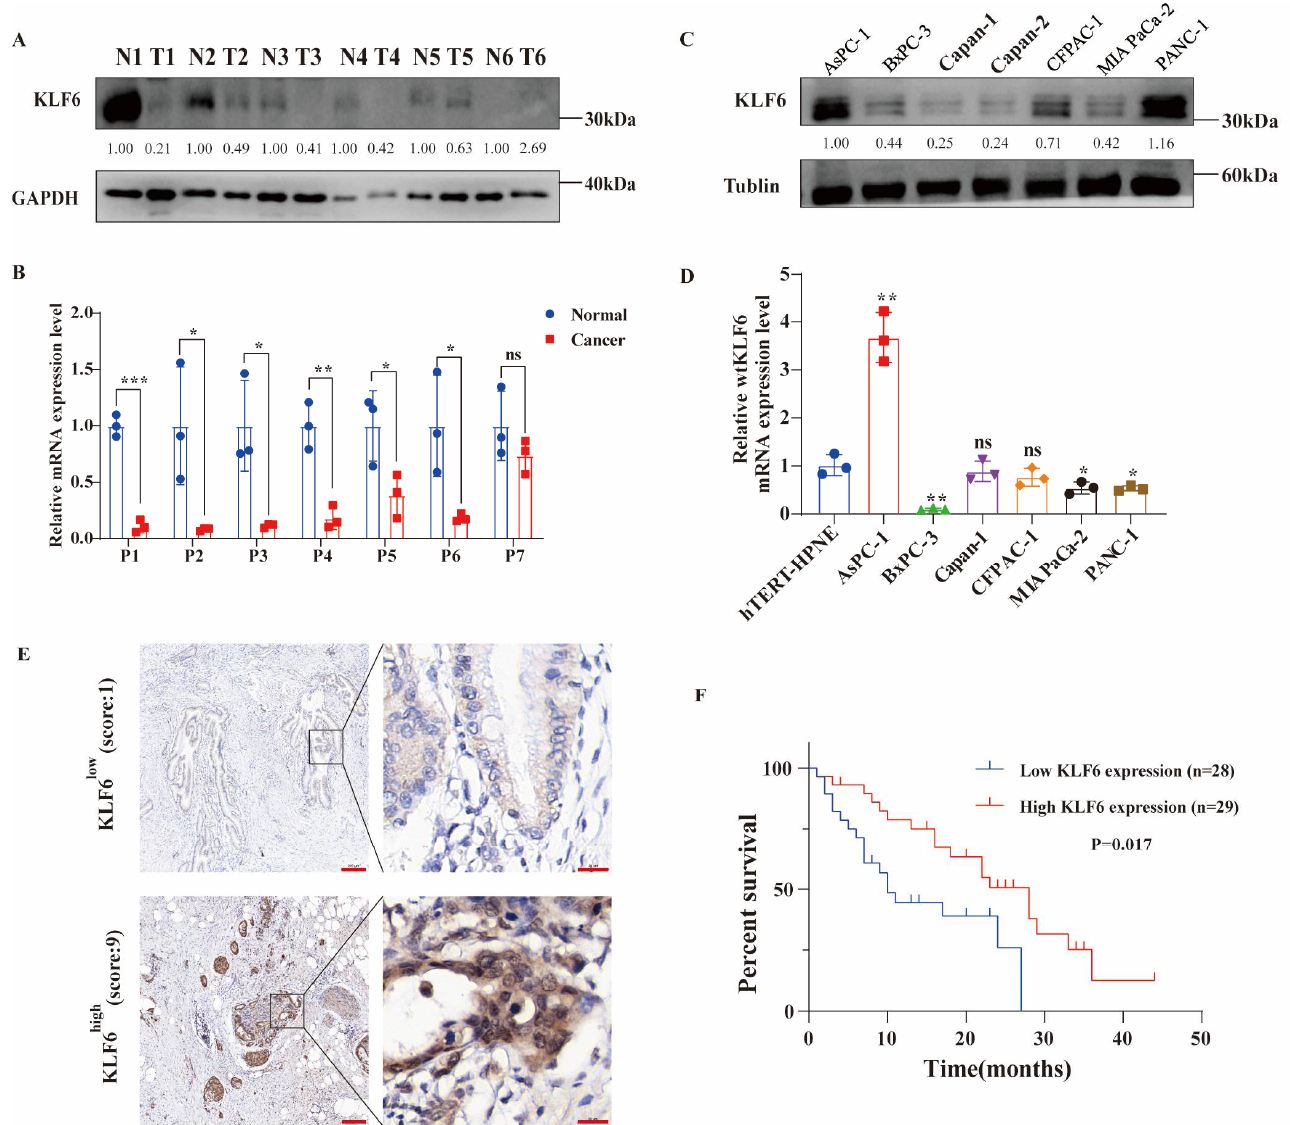
Figure 1. The expression pattern and prognostic value of KLF6 in pancreatic cancer. ( A ) KLF6 pro- tein expression level comparison between tumor and paired normal tissues from 6 patients with pancreatic ductal adenocarcinoma. N: normal; T: tumor. ( B ) Relative KLF6 mRNA expression level comparison between tumor and paired normal tissues from 7 patients with pancreatic ductal ade- nocarcinoma. P: patient. Data represent mean ± SD; n = 3. * p < 0.05, ** p < 0.01, *** p < 0.001, ns means no significance. ( C ) KLF6 protein expression level in pancreatic cancer cell lines. ( D ) Relative mRNA expression of KLF6 in pancreatic cancer cell lines and a normal pancreatic ductal cell line. Data represent mean ± SD; n = 3. * p < 0.05, ** p < 0.01, *** p < 0.001, ns means no significance. ( E ) Repre- sentative immunohistochemical staining images of low KLF6 expression and high KLF6 expression in pancreatic ductal adenocarcinoma tissues (original magnification of left pictures ×100; original magnification of right pictures ×1260; scale bar of left pictures 200 μm; scale bar of right pictures 20 μm). ( F ) Kaplan-Meier survival curves of patients with pancreatic ductal adenocarcinoma ( n = 57).